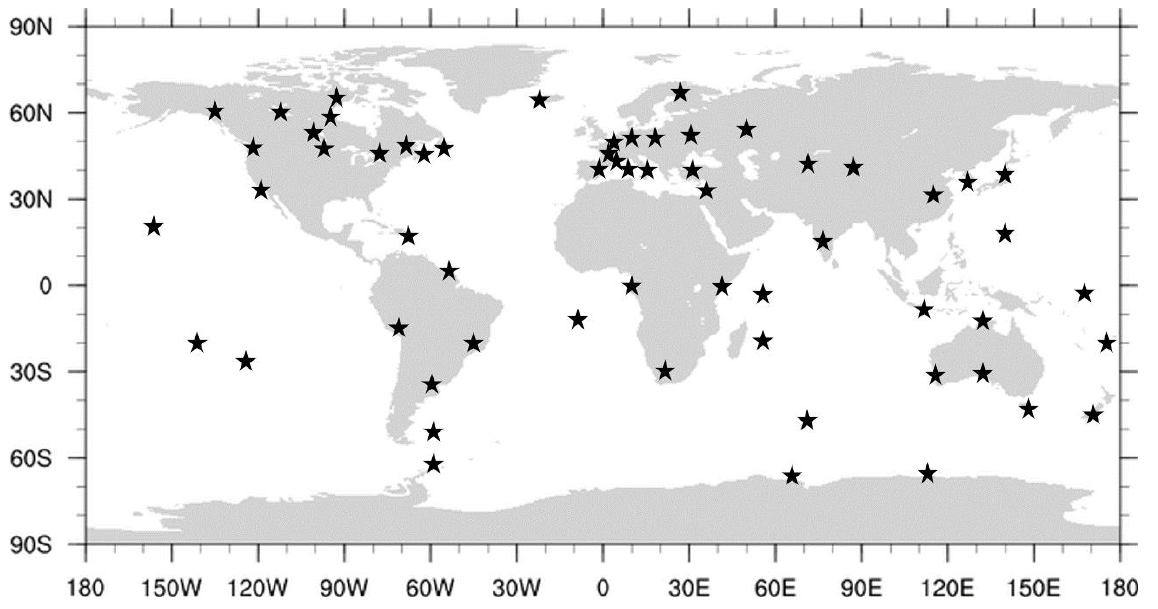
Figure 1. Distribution of the 60 IGS stations, the data of which were used in this study to generate the corrections. Table 3. Data processing strategy, observation models, and estimated parameters for network processing and user